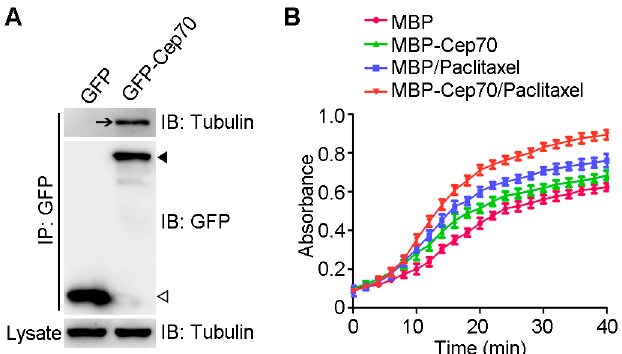
Figure 4. Cep70 promotes the capability of paclitaxel to induce microtubule assembly. ( A ) GFP-Cep70 or GFP was transfected into 293T cells, and immunoprecipitation was then carried out with anti-GFP antibody-conjugated agarose beads. Cell lysates and the immunoprecipitates were examined by immuoblot analysis with anti-tubulin or anti-GFP antibodies. IP represents immunoprecipitate, and IB represents immunoblot analysis. Arrow shows pull-down of tubulin. Black arrowhead and hollow arrowhead indicates immunoprecipitate of GFP-Cep70 and GFP, respectively; ( B ) MBP (Maltose binding protein) or MBP-Cep70 (10 µ M) was incubated with tubulin (10 µ M) at 37 ◦ C before adding paclitaxel (10 µ M), and the microtubule polymerization was detected by recording the optical absorbance at 350 nm. All data are presented as means ± standard deviations (SD), n = 3 per group.